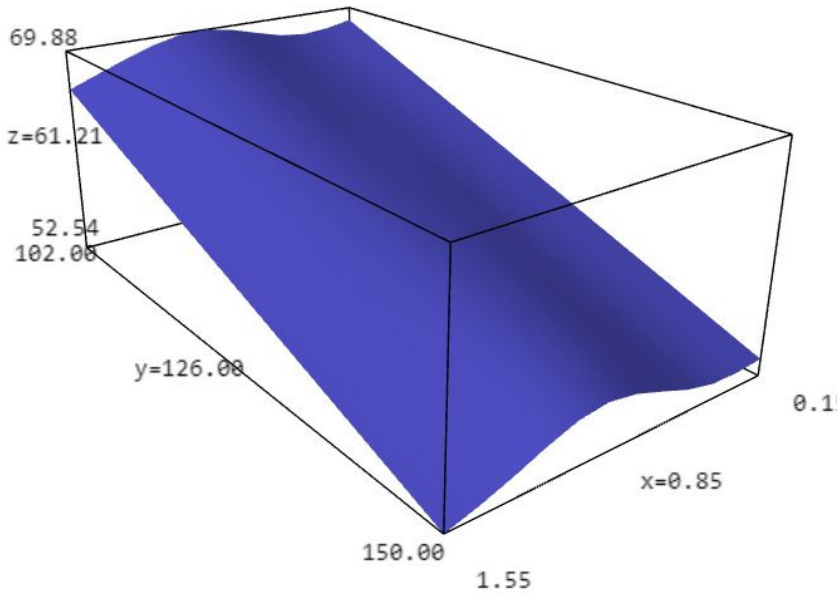
Figure 5. Dry matter dependence on temperature and particle size (x—particle size; y—temperature; z—dry matter)